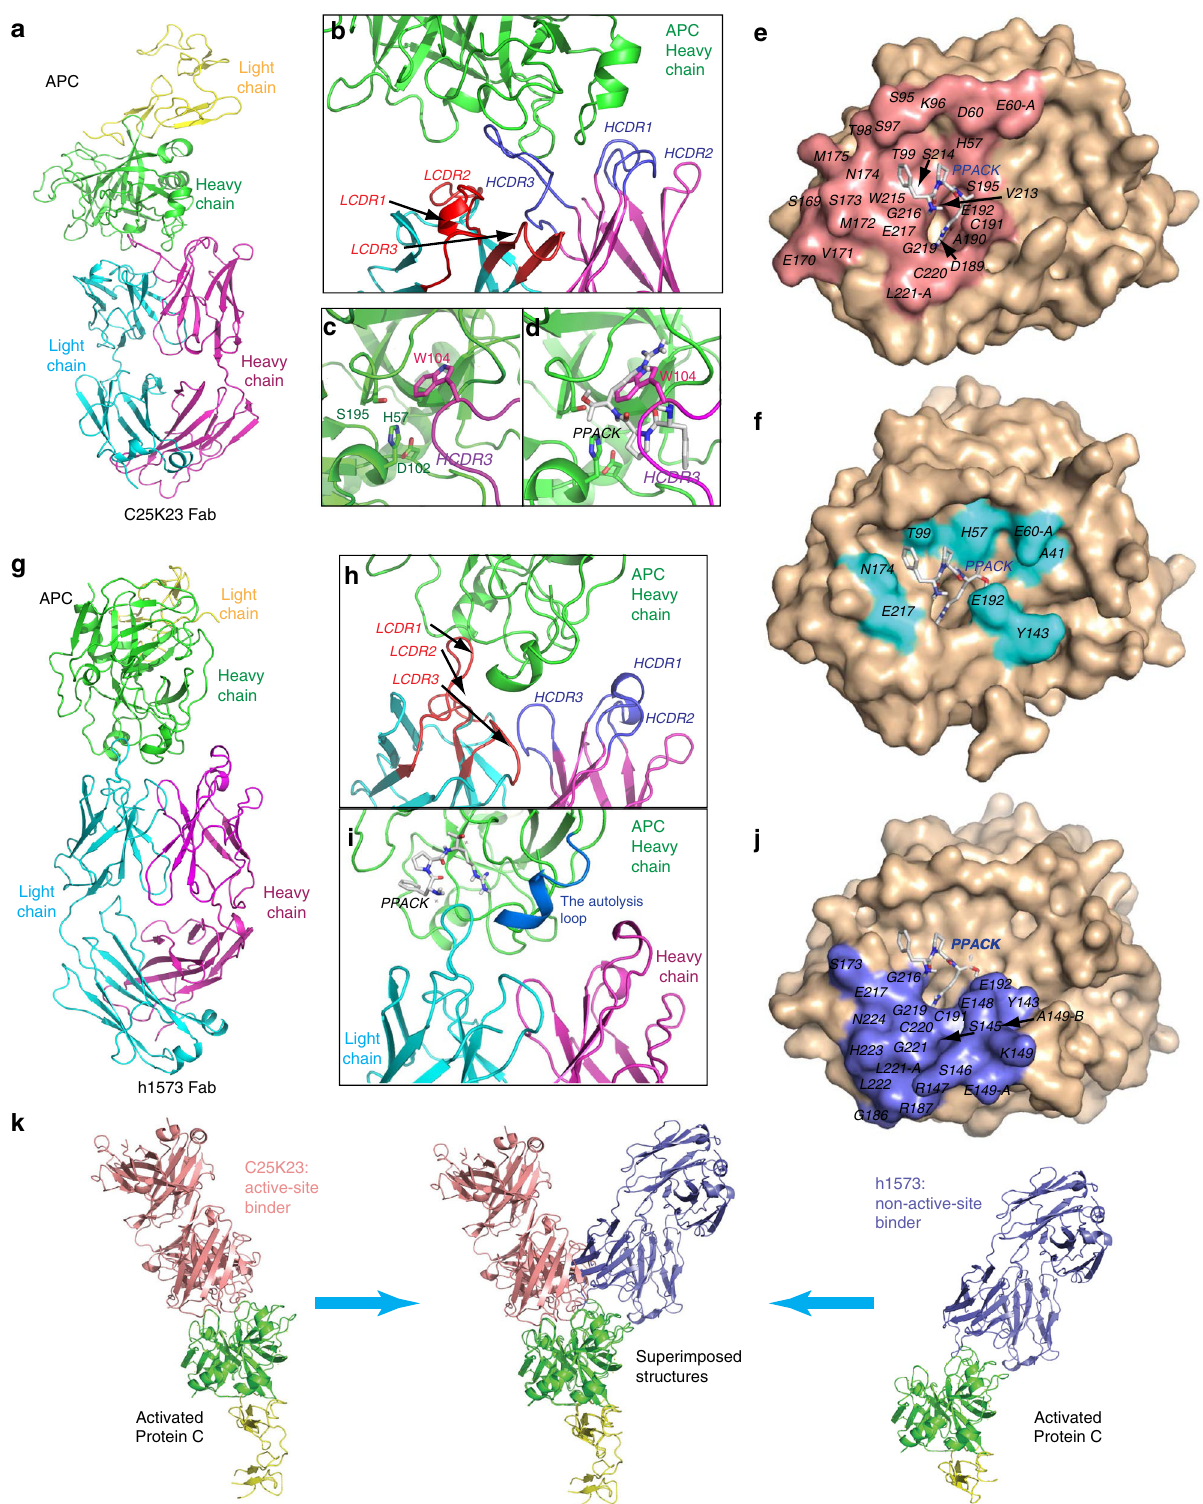
The crystal structure of hAPC – type II (h1573) Fab complex was determined at 3.7-Å resolution (Fig. 2g; Table 1). The LCDR1 loop of the h1573Fab played a major role in binding to APC (Fig. 2h; Supplementary Fig. 2b). The binding of h1573Fab to APC did not have much steric overlap with PPACK (Fig. 2i). Upon h1573Fab binding, conformation of the His144 – Thr152 loop (chymotrypsin numbering 16 ) of APC (the autolysis